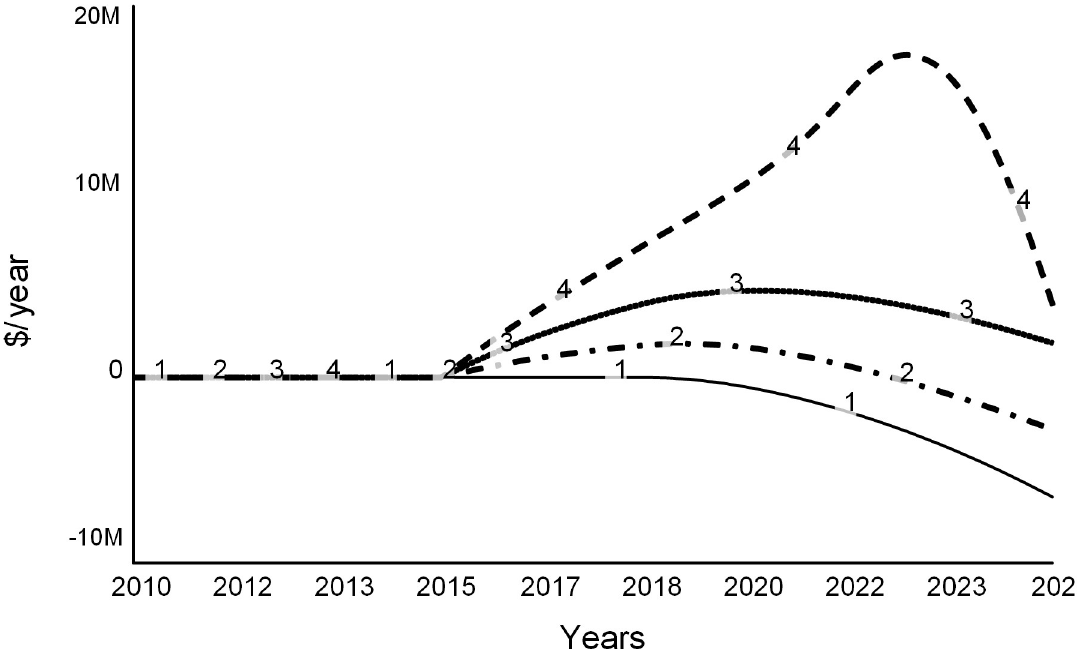
Fig 13. Net revenue at different levels of hiring. Curve 1 is the base run: all searchers are allowed. Curve 2: 75% of searches allowed. Curve 3: 50% of searchers allowed, and Curve 4: 25% of searches allowed.